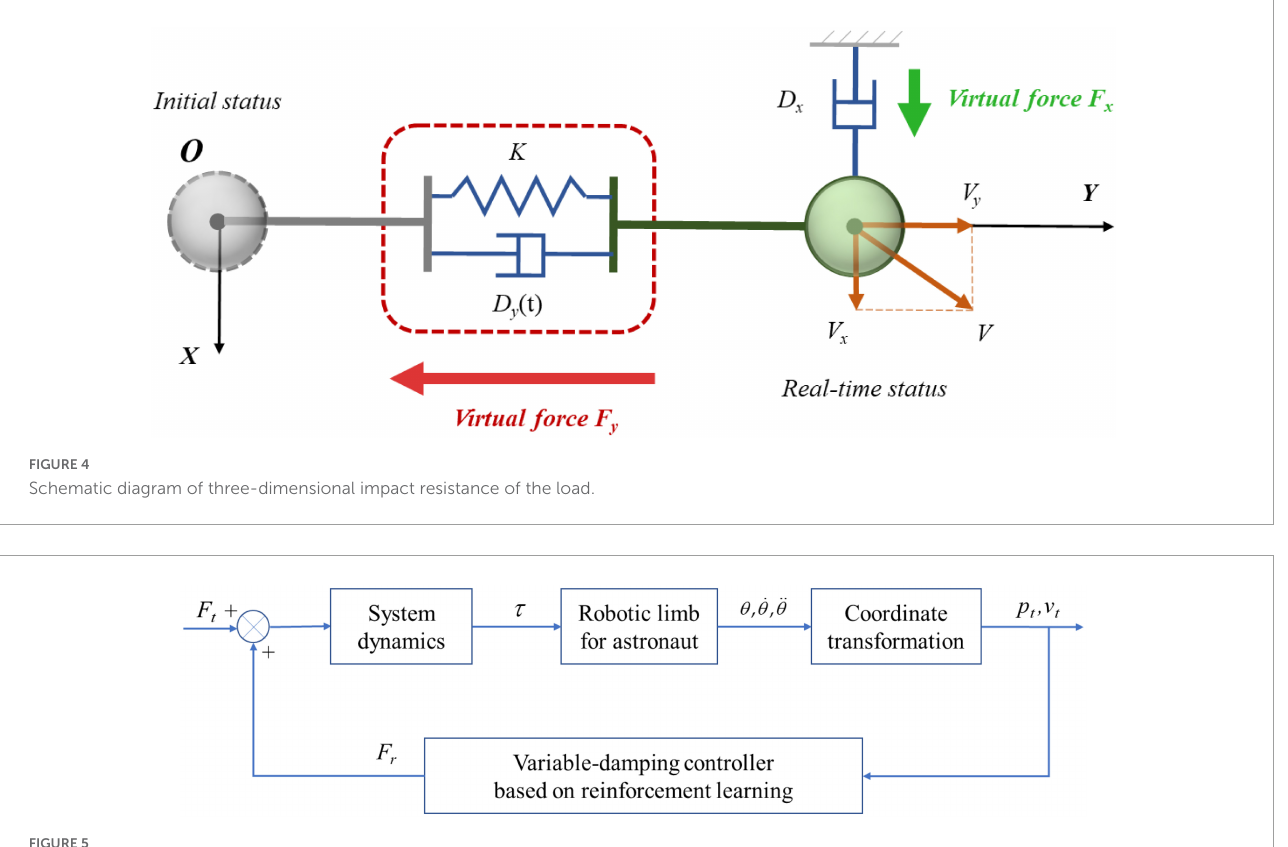
FIGURE5 Framework of the variable-damping control method.